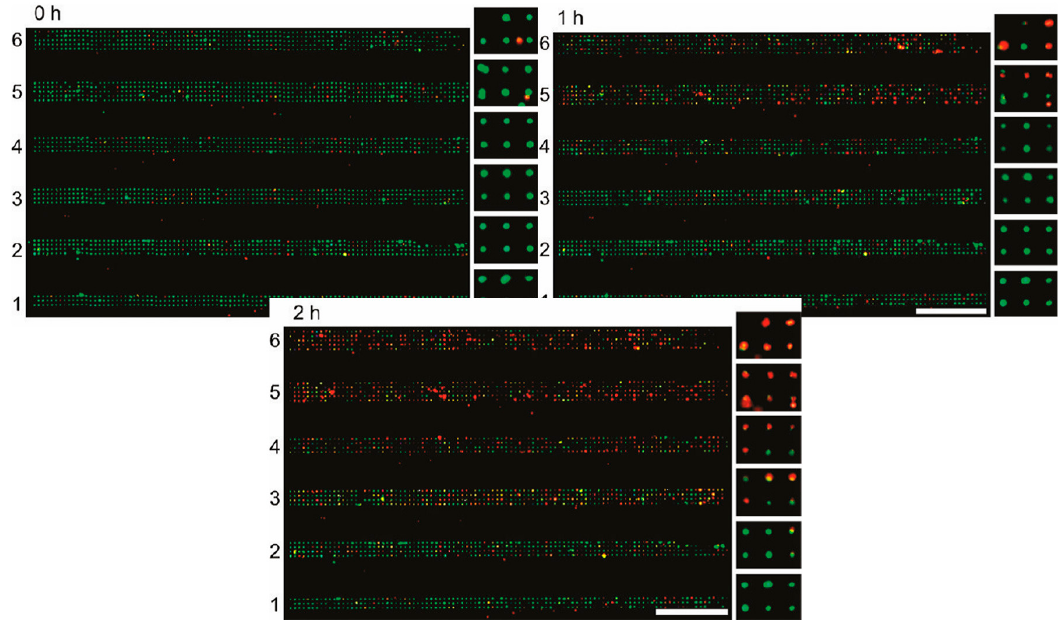
Figure 2. Six parallel channels containing single-cellular microwell arrays after exposure to gradients of KCN, green indicates viable cells and red indicates lysed cells, scale bar = 1 mm. Adapted with permission from Analytical Chemistry 83(10) Hosokawa, Hayashi [37]. Copyright 2011 American Chemical Society.